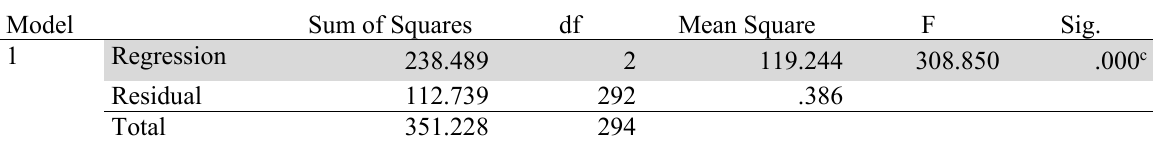
Regression analysis between ACAP, DL and IP Model